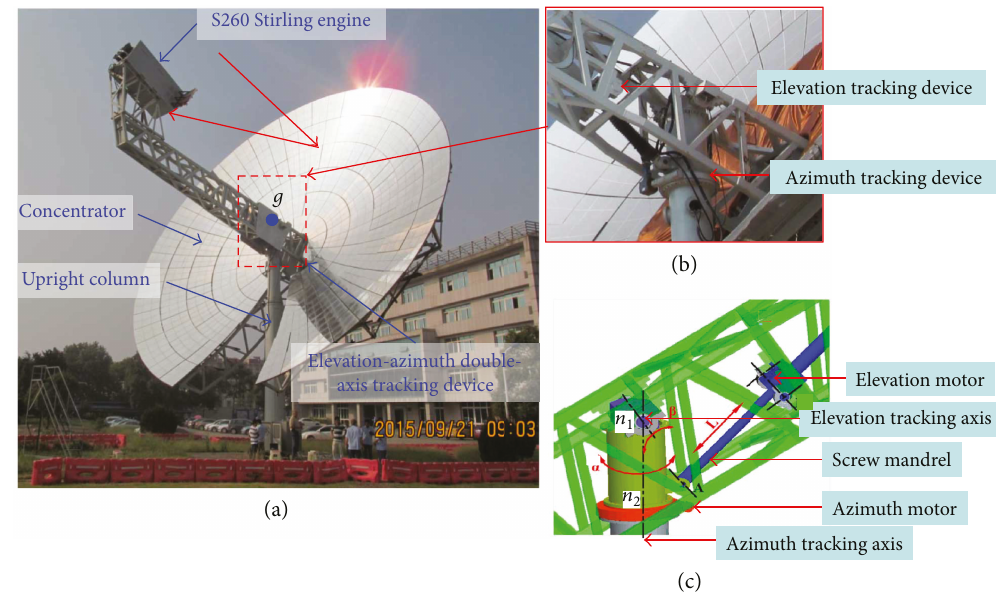
Figure 1: A 38kW dish-Stirling solar thermal power system (38 kW XEM-Dish system). The diameter is 17.70m and the focal length is 9.49m of the parabolic dish concentrator and was built in Xiangtan Electric Manufacturing Group,